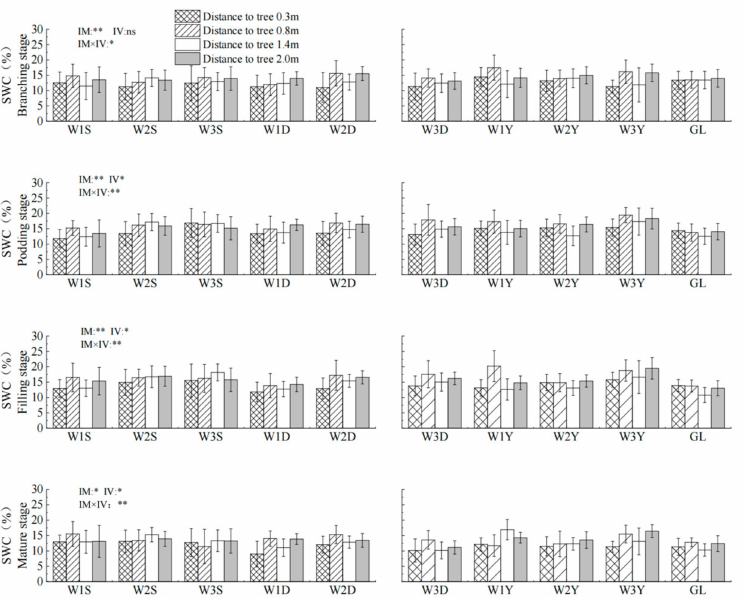
Figure 5. Dynamics of soil water content levels during the soybean reproductive period. Note: * indicates significant correlation ( p < 0.05); ** is highly significant ( p < 0.01); ns is insignificant correlation ( p > 0.05). IM is irrigation method and IV is irrigation